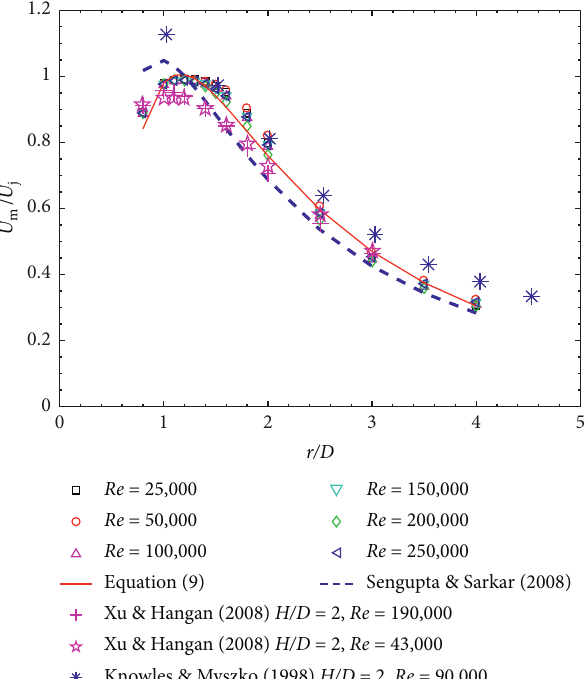
Figure 18: Decay of maximum mean radial velocity for different Reynolds